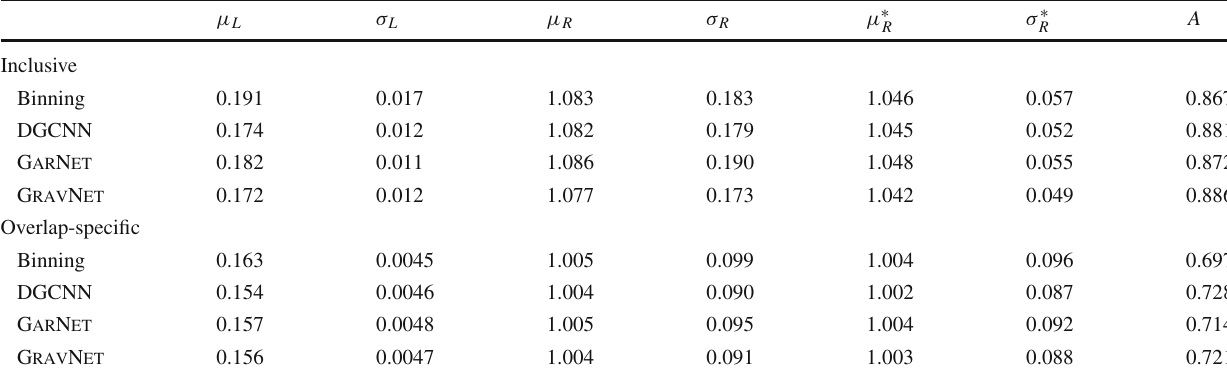
Table 2 Mean and variance of loss, response, and response within the Gaussian kernel as well as clustering accuracy